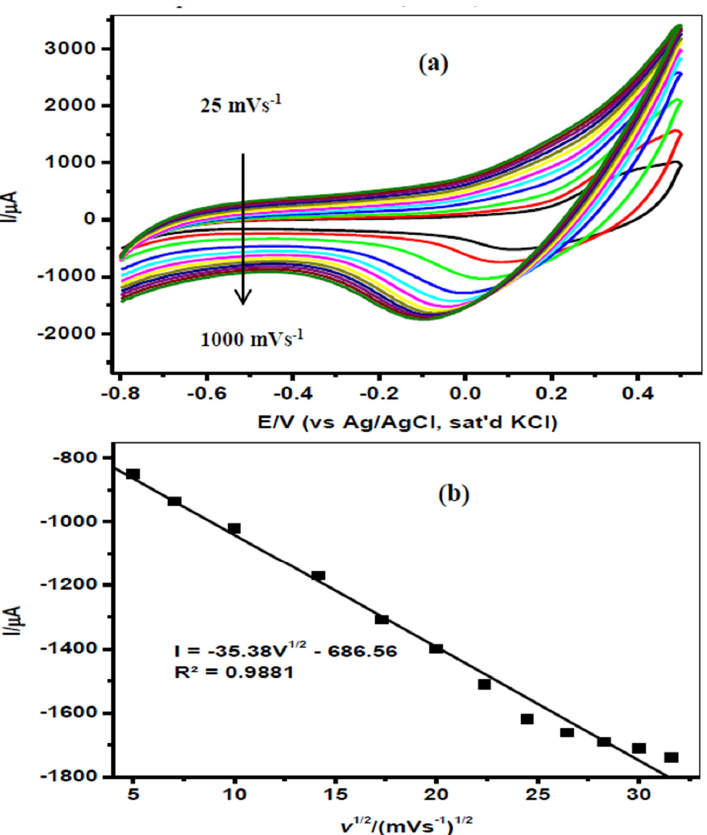
Figure 2. ( a ) Cyclic voltammograms of AONPs-PANI-SWCNT-modified GCE in 86 µM EDS prepared in 2:1 water/acetonitrile containing 0.1M H 2 SO 4 at a scan rate of 25–1000 mVs − 1 . ( b ) Plot of the anodic peak current (I pa ) versus the square root of the scan rate ( v ) for AONP-PANI-SWCNT-modified GCE in EDS.